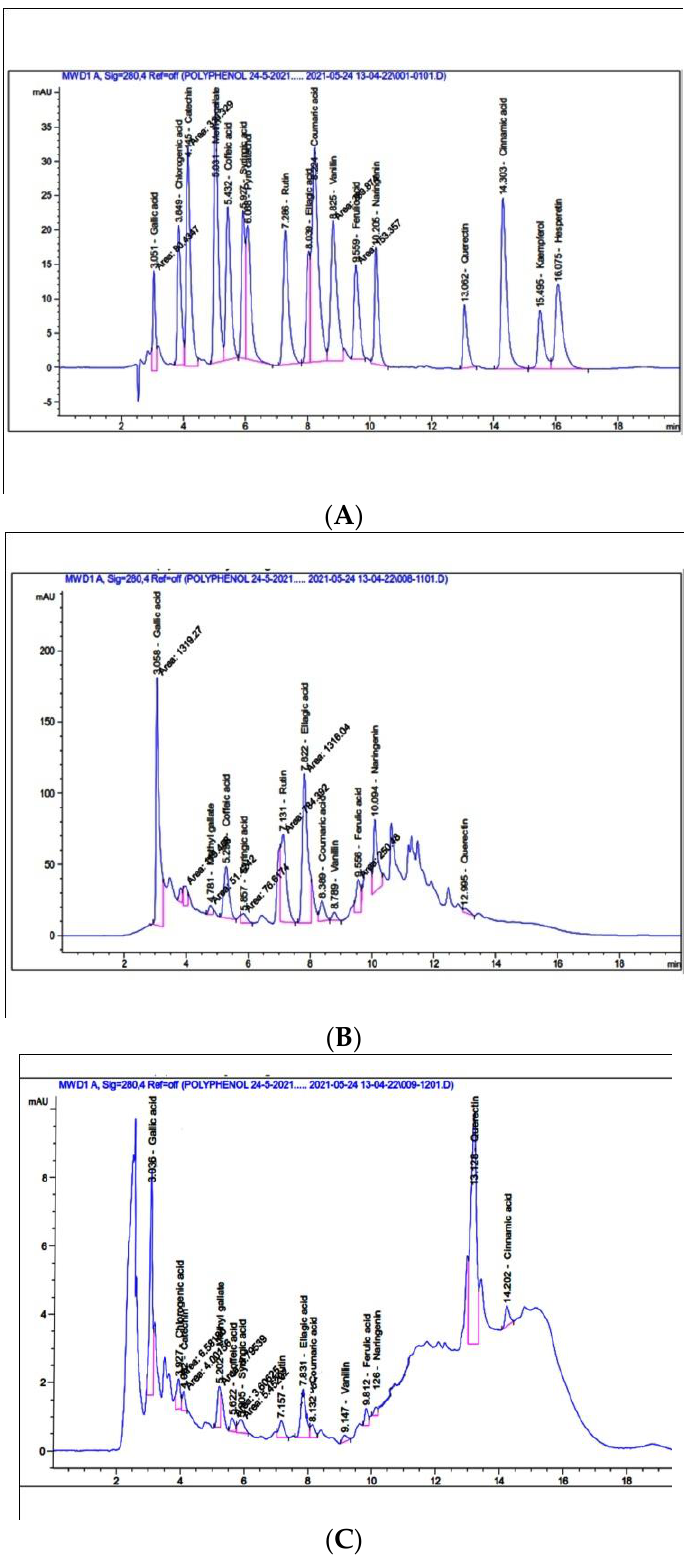
Figure 1. ( A ). HPLC Chromatogram of phenolic compounds reference material (standards), ( B ). HPLC Chromatogram of phenolic compounds in methanolic leaves extract of Z. spina-christi , ( C ). HPLC Chromatogram of phenolic compounds in methanolic fruits extract of Z. spina-christi .